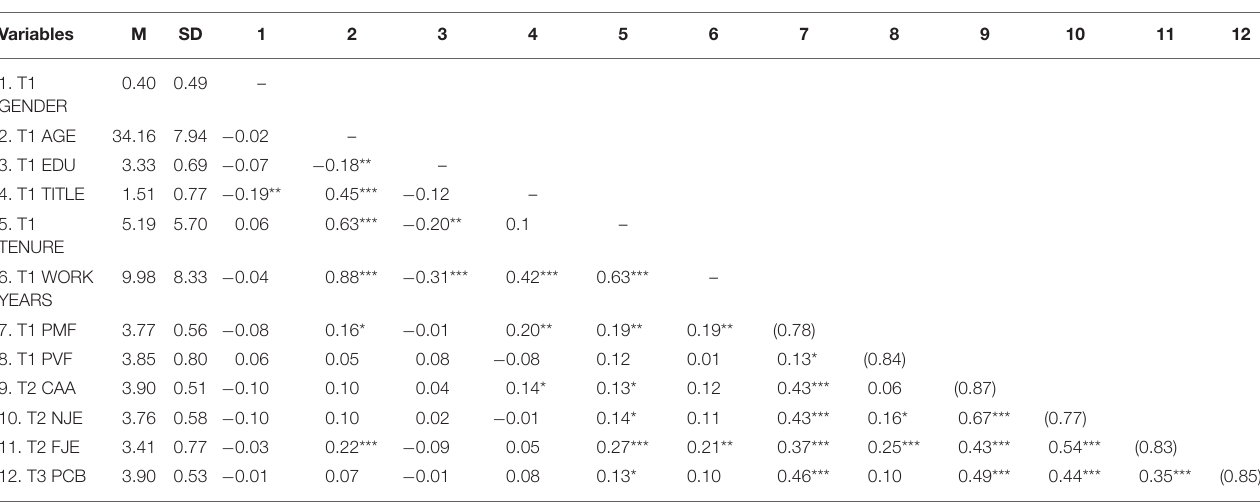
TABLE 1 | Means, SD, and correlations among the study variables. Variables